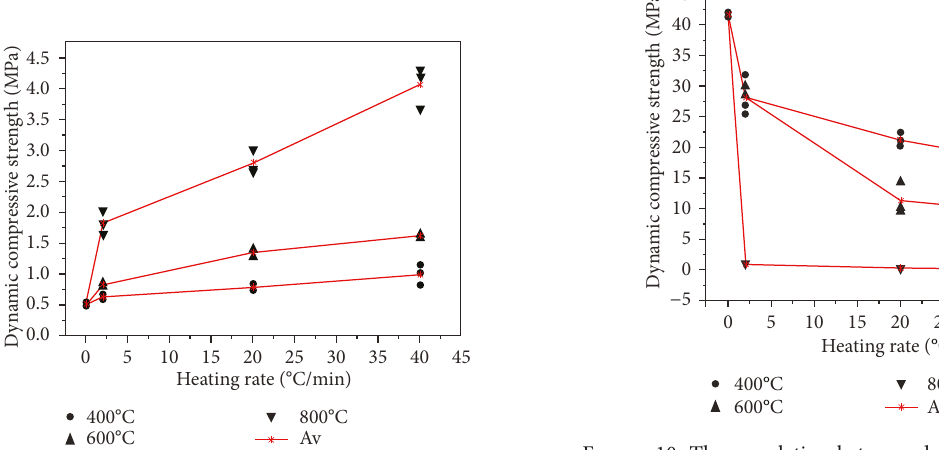
Figure 10: The correlation between dynamic elastic modulus and heating